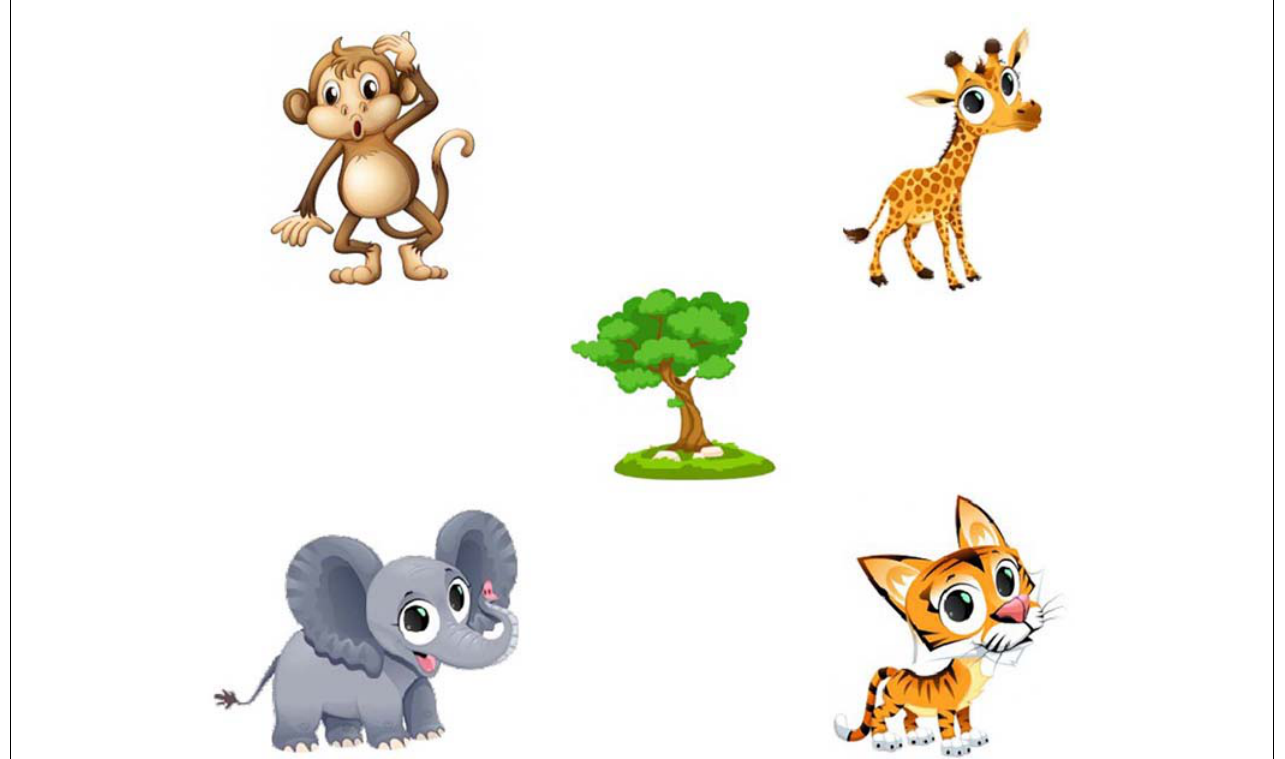
FIGURE 1 | Example of experimental item screen